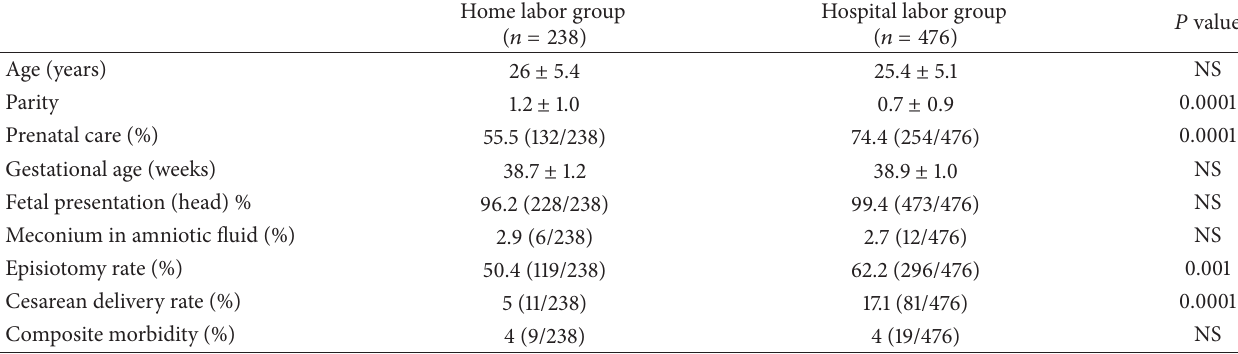
Table 1: Comparisons of demographic data and pregnancy outcomes of pregnancies with home and hospital labor.